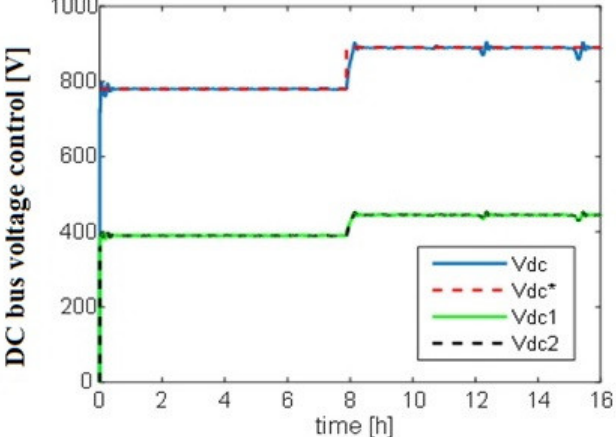
Figure 15. Load voltage control results using an NPC inverter.